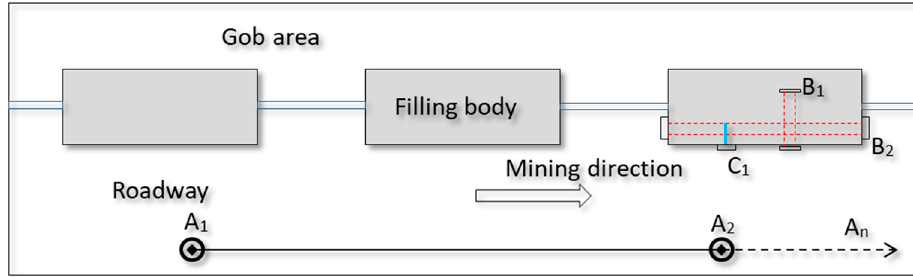
Figure 15. Schematic diagram of observation station arrangement.